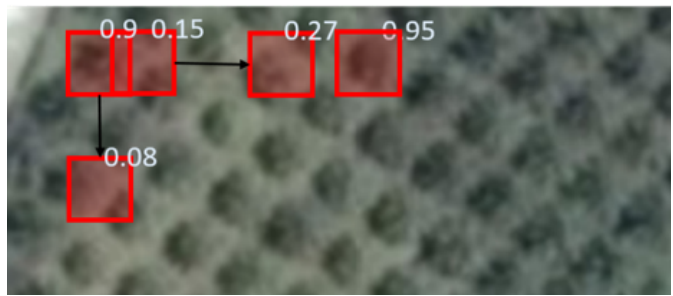
Figure 8. Sliding window for label prediction.